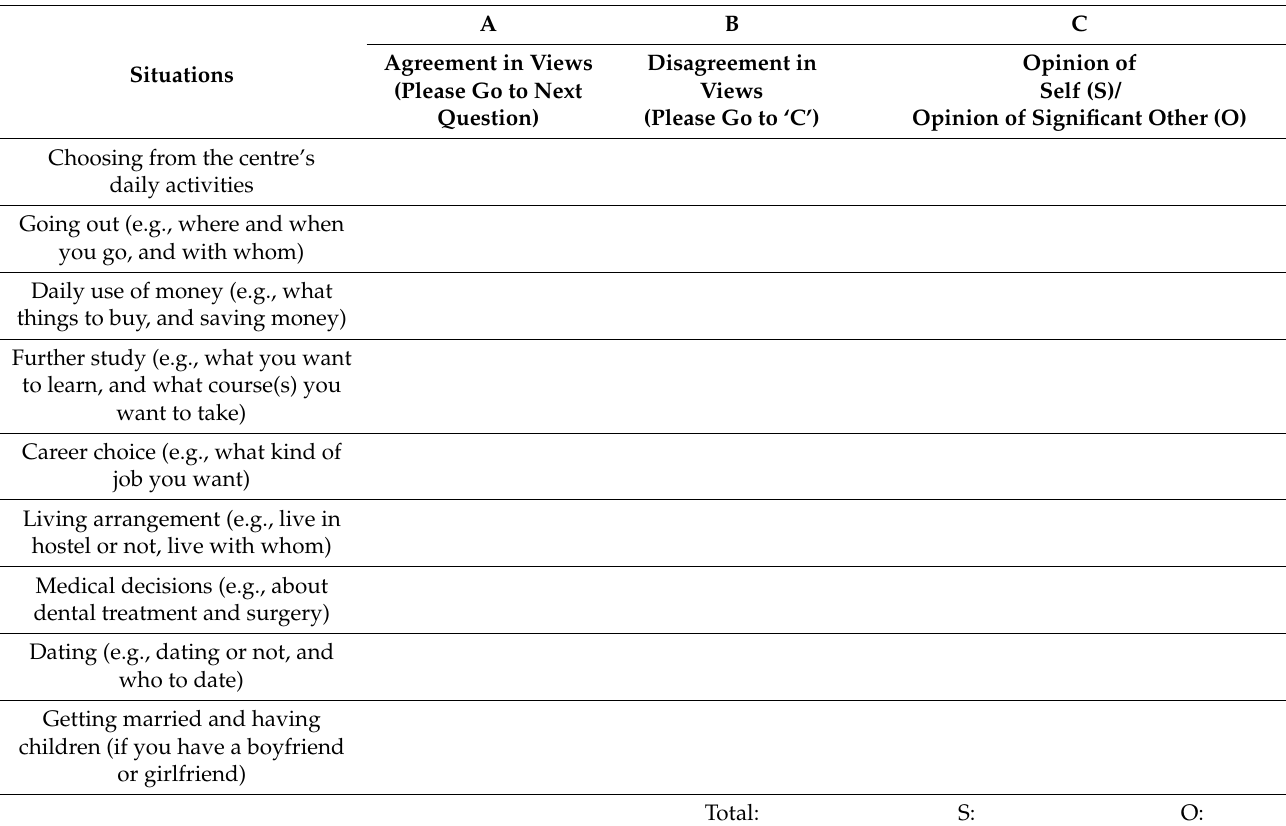
Table 2. Decision-Making Patterns in Agreement/Disagreement